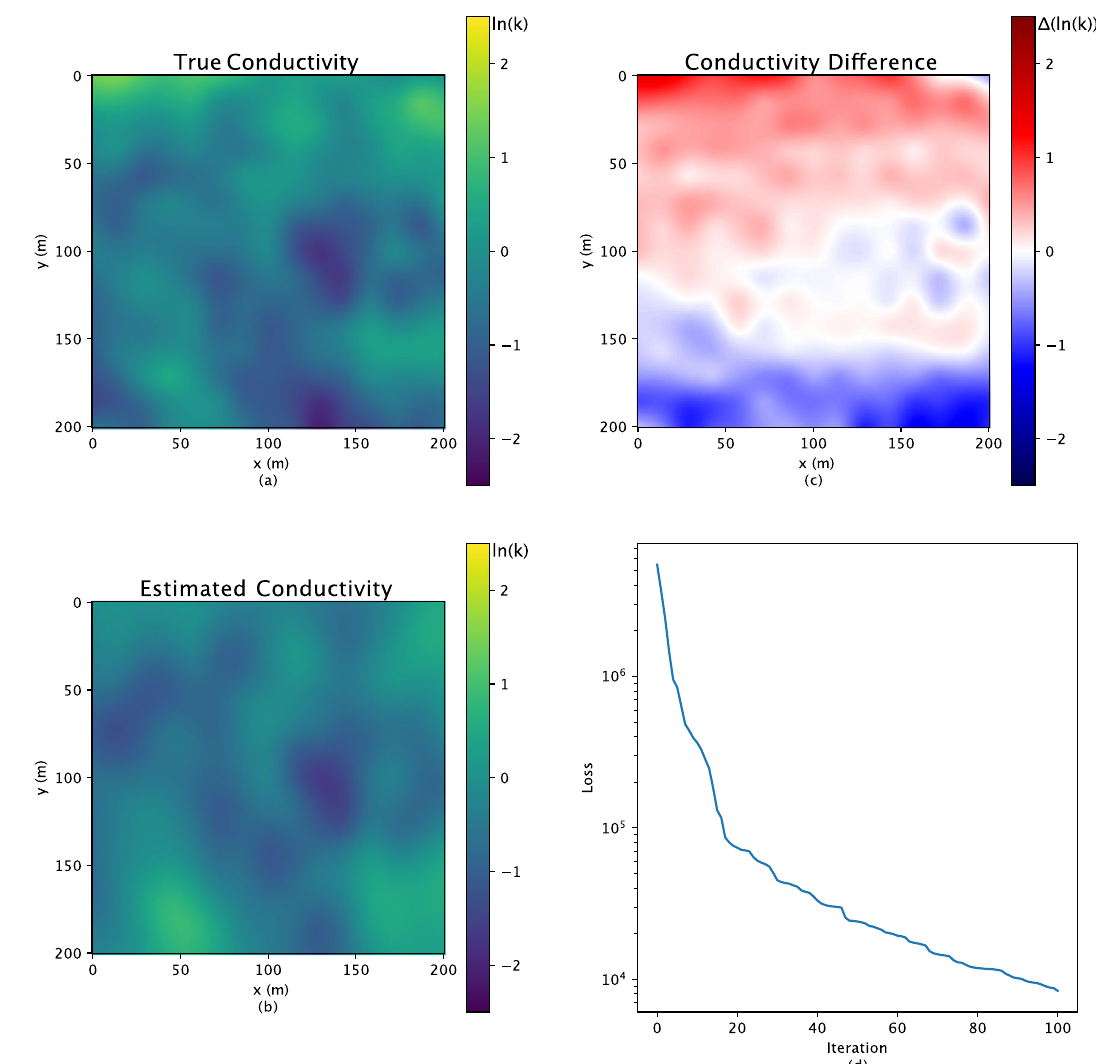
Figure 2. The reference conductivity field is shown in subfigure ( a ), and the corresponding inverse results are shown in subfigure ( b ). The hydraulic conductivity shows on the ln scale. Subfigure ( c ) shows the difference between the related reference fields and the inverse results. The convergence of the inverse analysis is shown in subfigure ( d